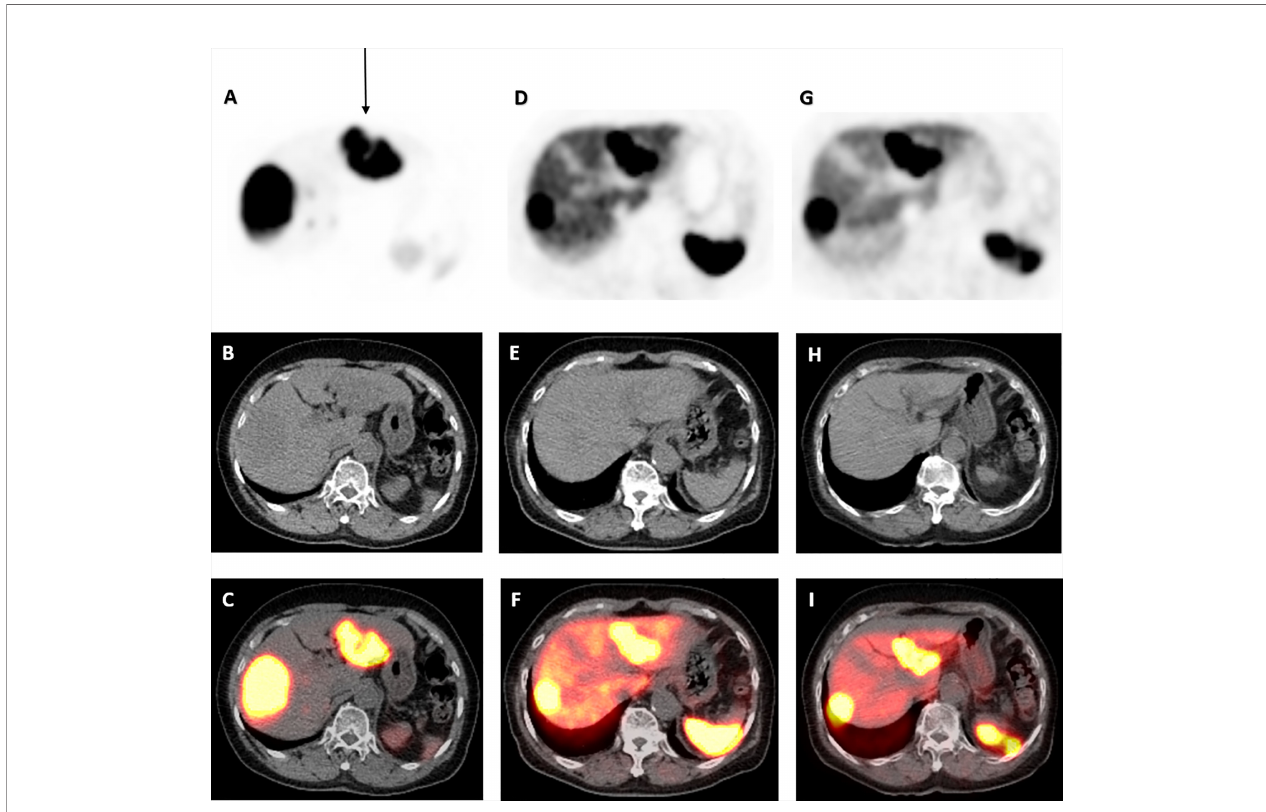
FIGURE 3 | 68Ga-DOTATATE PET/CT scan images of dominant left liver lobe lesion pre- and post-177 Lu-DOTATATE. Axial view images of 68 Ga-DOTATATE PET/ CT scan demonstrating interval reduction in size in dominant left liver lobe lesion (arrow) on PET, low-dose CT, and PET/CT fusion (top to bottom) from baseline, to 1 and 4 years after 177 Lu-DOTATATE therapy (left to right). Physiological uptake in the spleen and remainder of the liver is also